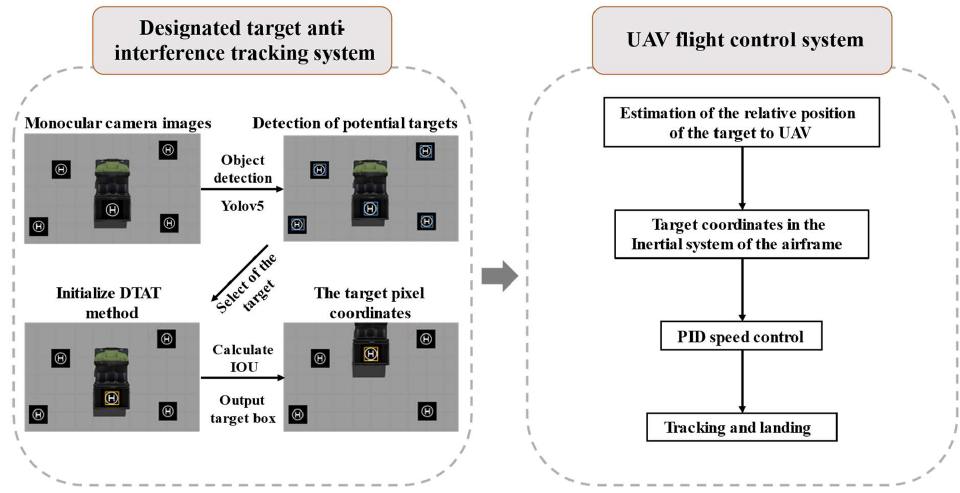
Figure 1. UAV autonomous tracking and landing